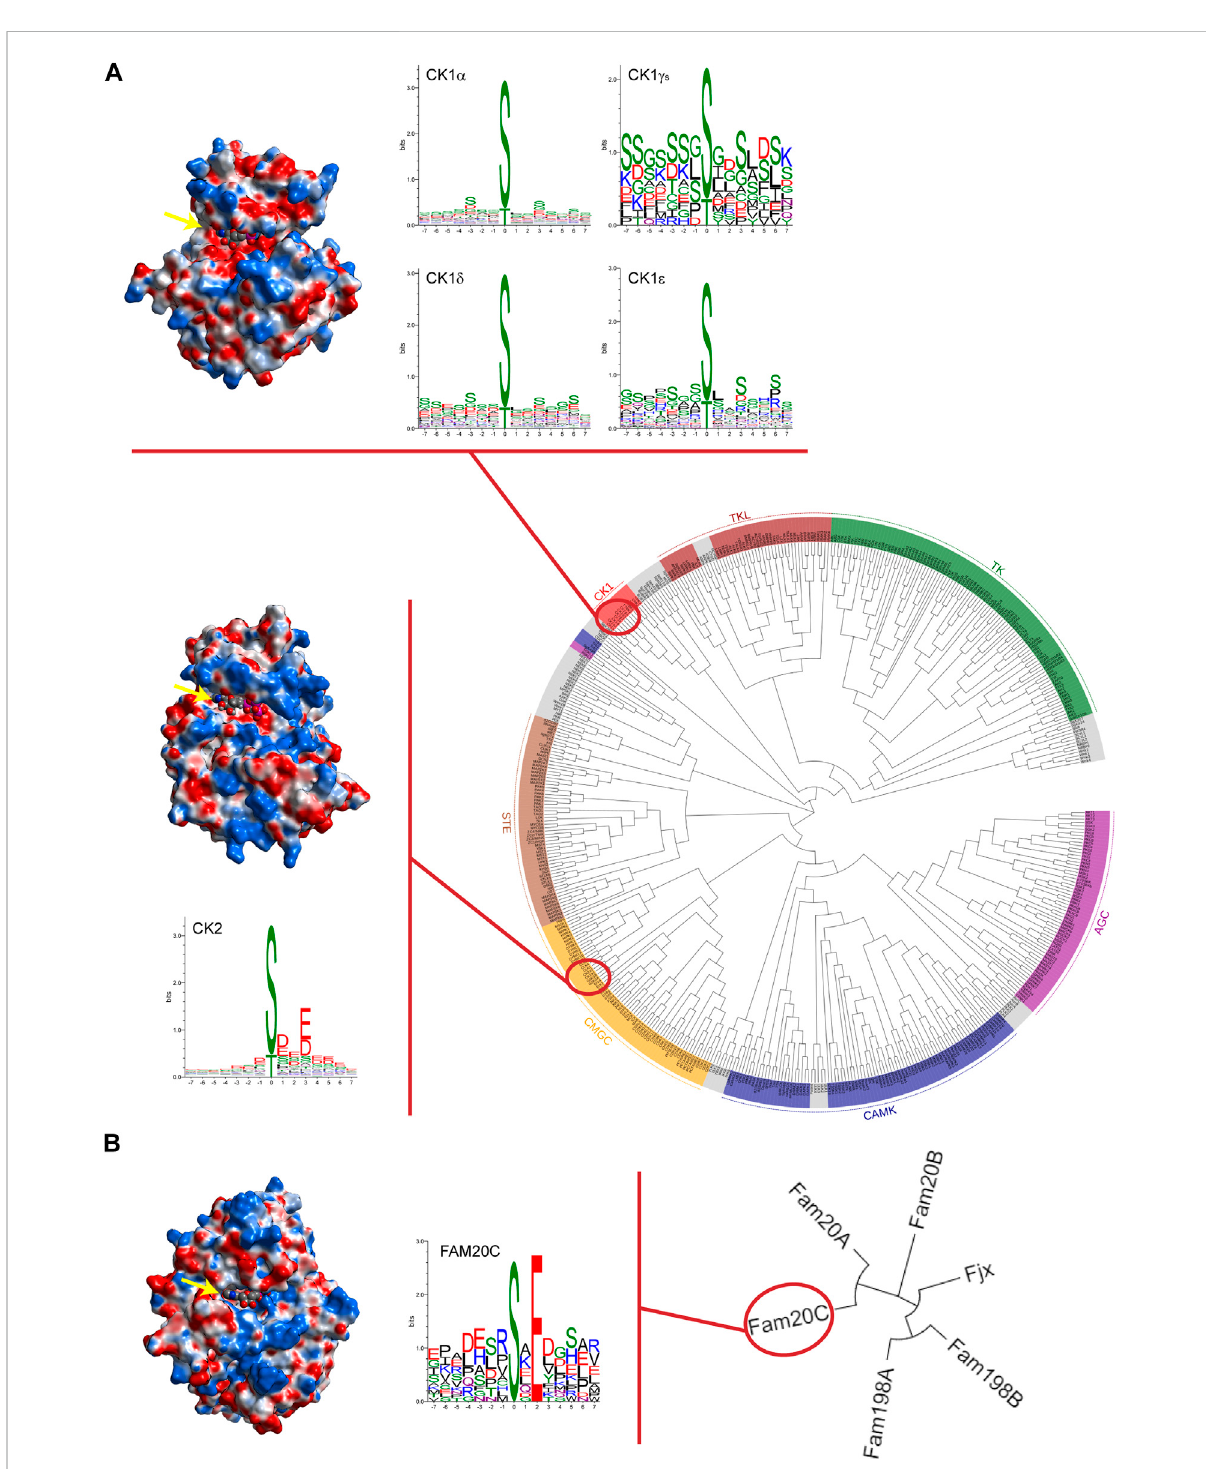
Casein kinases at a glance. (A) Phylogenetic dendrogram of the human kinome in which major groups of canonical protein kinases are labelled and coloured. Protein kinases CK1 and CK2 are highlighted. In the upper part, CK1 δ tridimensional structure (PDB code 7P7H) is reported as an illustrative example of the CK1 family comprising six different isoforms and WebLogos for each isoform are depicted. For CK1 γ isoforms (namely CK1 γ 1, CK1 γ 2, and CK1 γ 3), a single WebLogo of merged substrate sequences phosphorylated by the three isoforms is displayed. In the lower part, crystal structure of α catalytic subunit of protein kinase CK2 (PDB code 3WOW) and WebLogo analysis of CK2 holoenzyme ’ s known substrates arereported. (B) Phylogenetic tree oftheFour-Jointedfamilyofatypicalproteinkinases.Due totheiraltered aminoacidsequencesinrespect